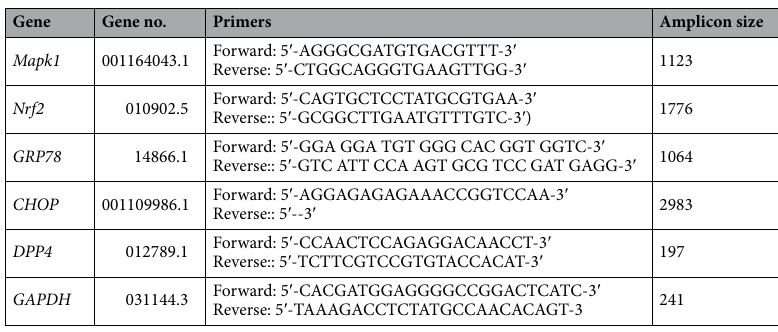
Table 1. Sequence specific